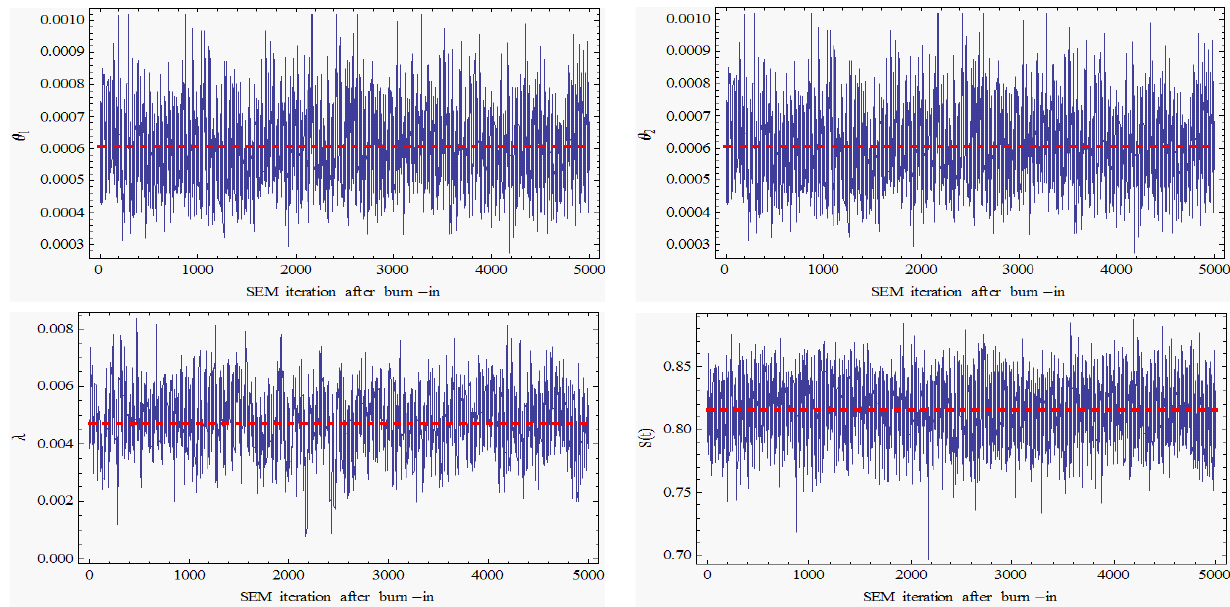
Fig. 7. Traces plot of SEM samples based on the data from Xia et al. (2009). Horizontal lines are the estimated parameter values.